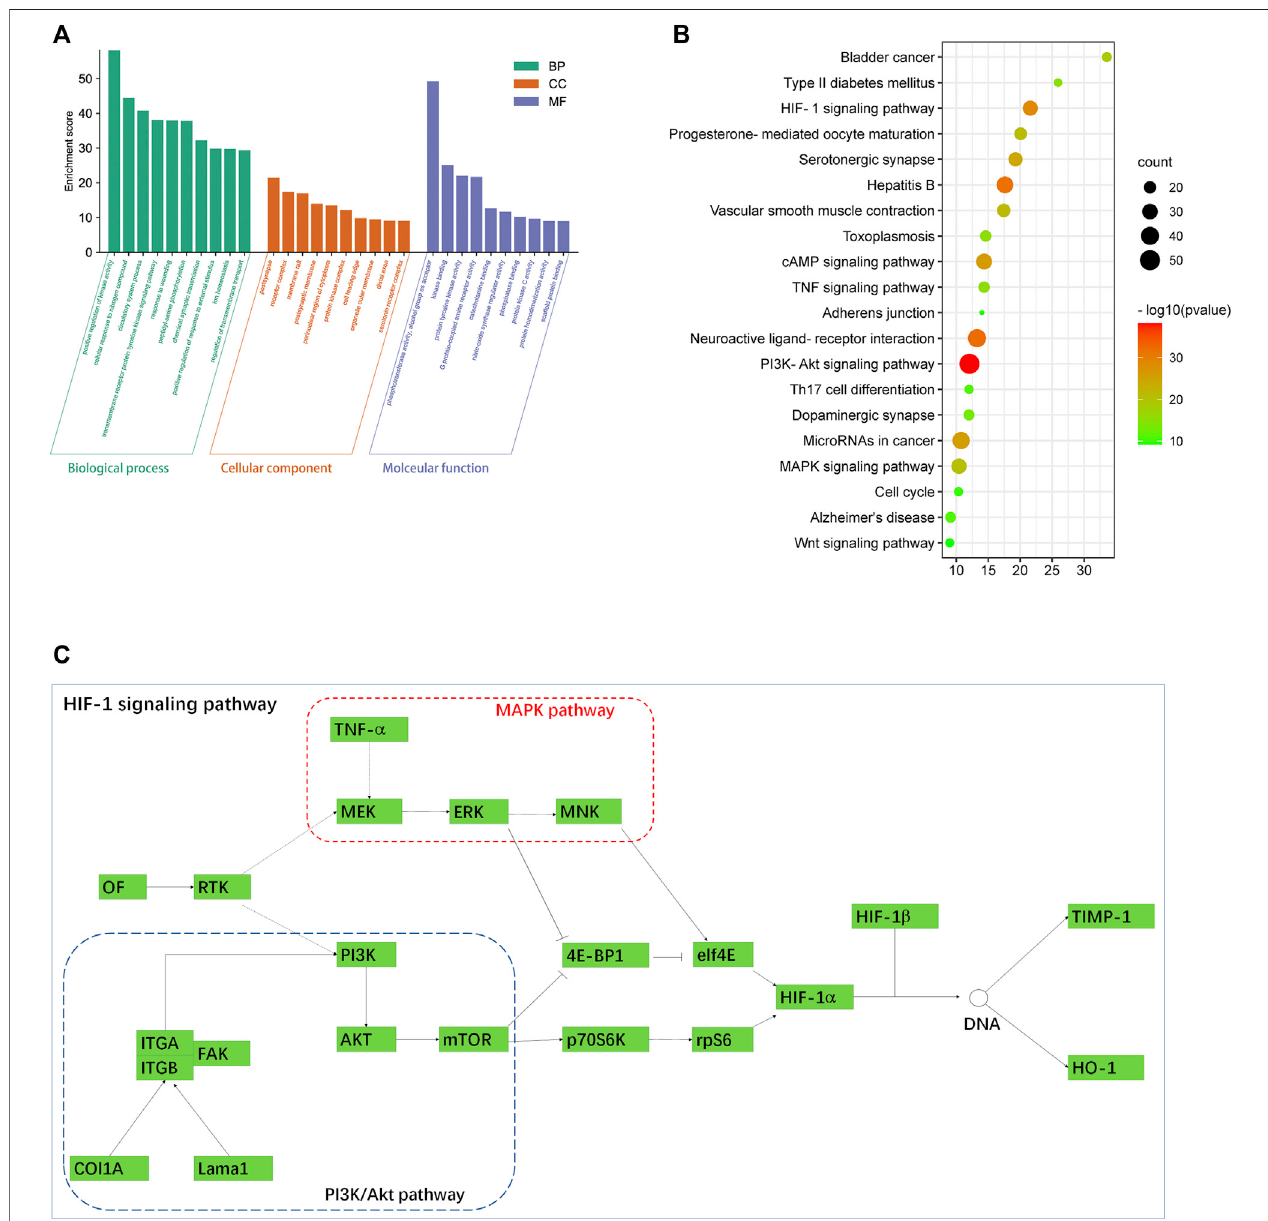
FIGURE 6 | (A) GO enrichment analysis by the Metascape database. (B) Bubble chart of the target-enriched KEGG pathways. The bubble size represents the numberofthetargets intheenriched pathway terms,and thebubble colorrepresentsthe pathway ’ s p -value.TheHIF-1pathway wasfoundedtohaveahighnumberof targets enriched and a signi fi cant p -value. (C) HIF-1 pathway and its associated signaling pathways. Data were retrieved from the KEGG database (https://www. genome.jp/kegg/).